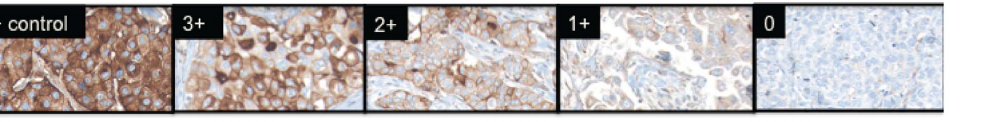
Figure 4. Immunohistochemical staining for GRM1 on tissue microarrays of human breast tissue. Representative examples of the IHC scoring system using breast cancer tissues are shown. Melanoma (left panel) was utilized as a positive control and for antibody optimization. Scoring was based on intensity of membrane staining: 0; 1 + ; 2 + ; 3 + .